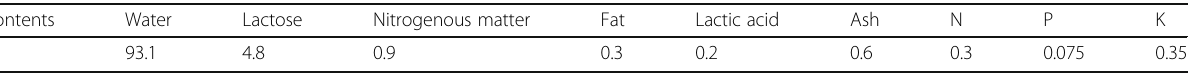
Table 2 Chemical content of milk